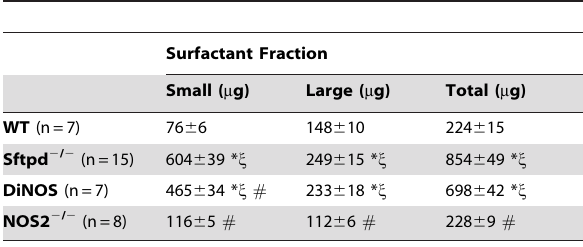
Table 3. Lung function data: Parameter values from model fits.